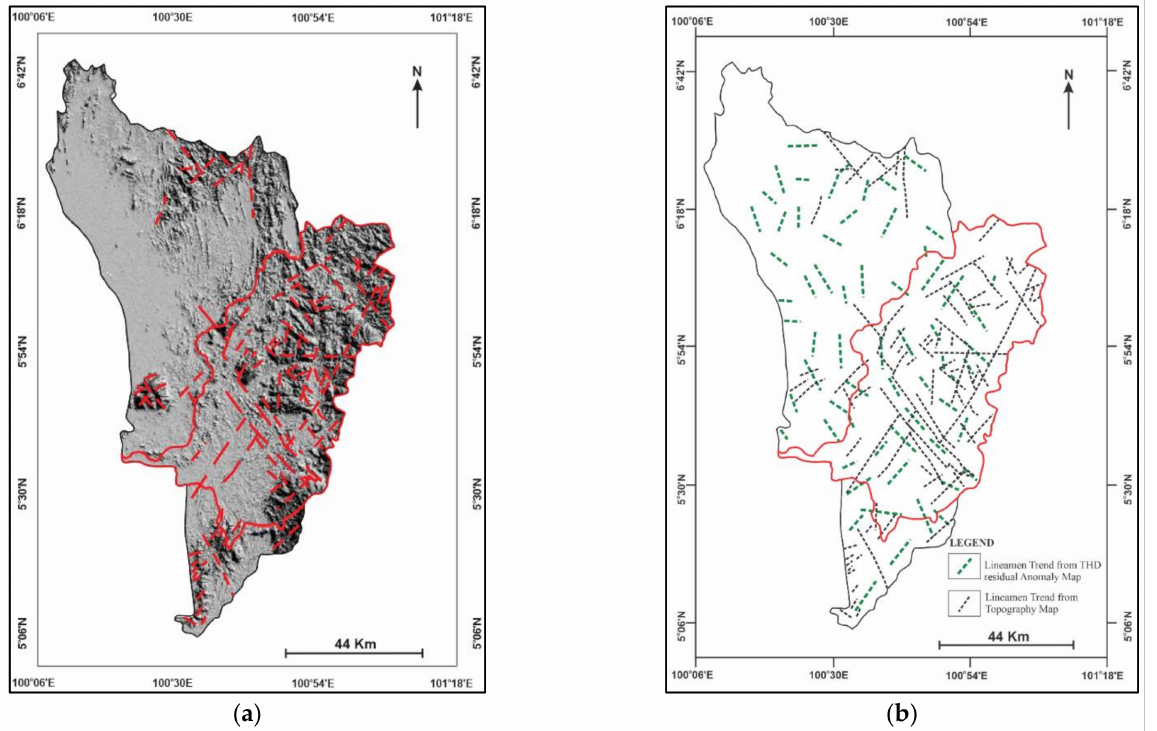
Figure 7. ( a ) Lineament traced from topography map; ( b ) Comparison of lineament trend traced from THD residual anomaly map and topography